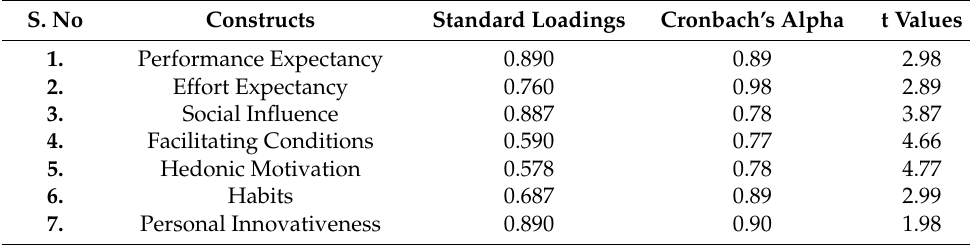
Figure 2. CFA for all study scales. Table 2. Standard loadings, Cronbach’s Alpha, and t